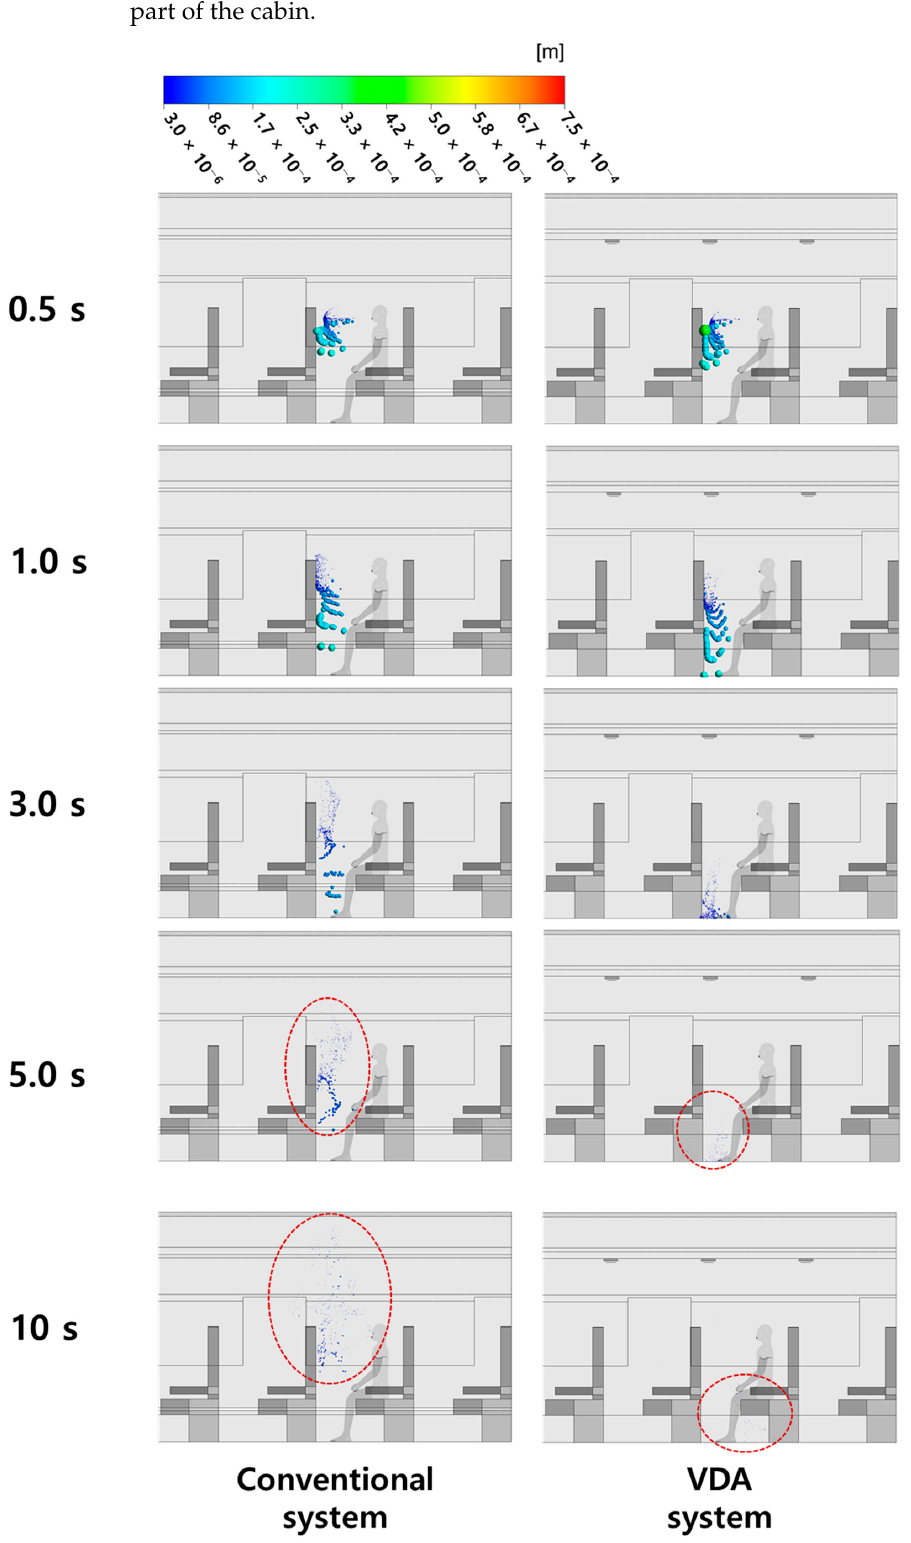
Figure 7. Droplet distributions in the conventional and VDA systems between 0 and 10 s after coughing. Relative droplet size is observed.